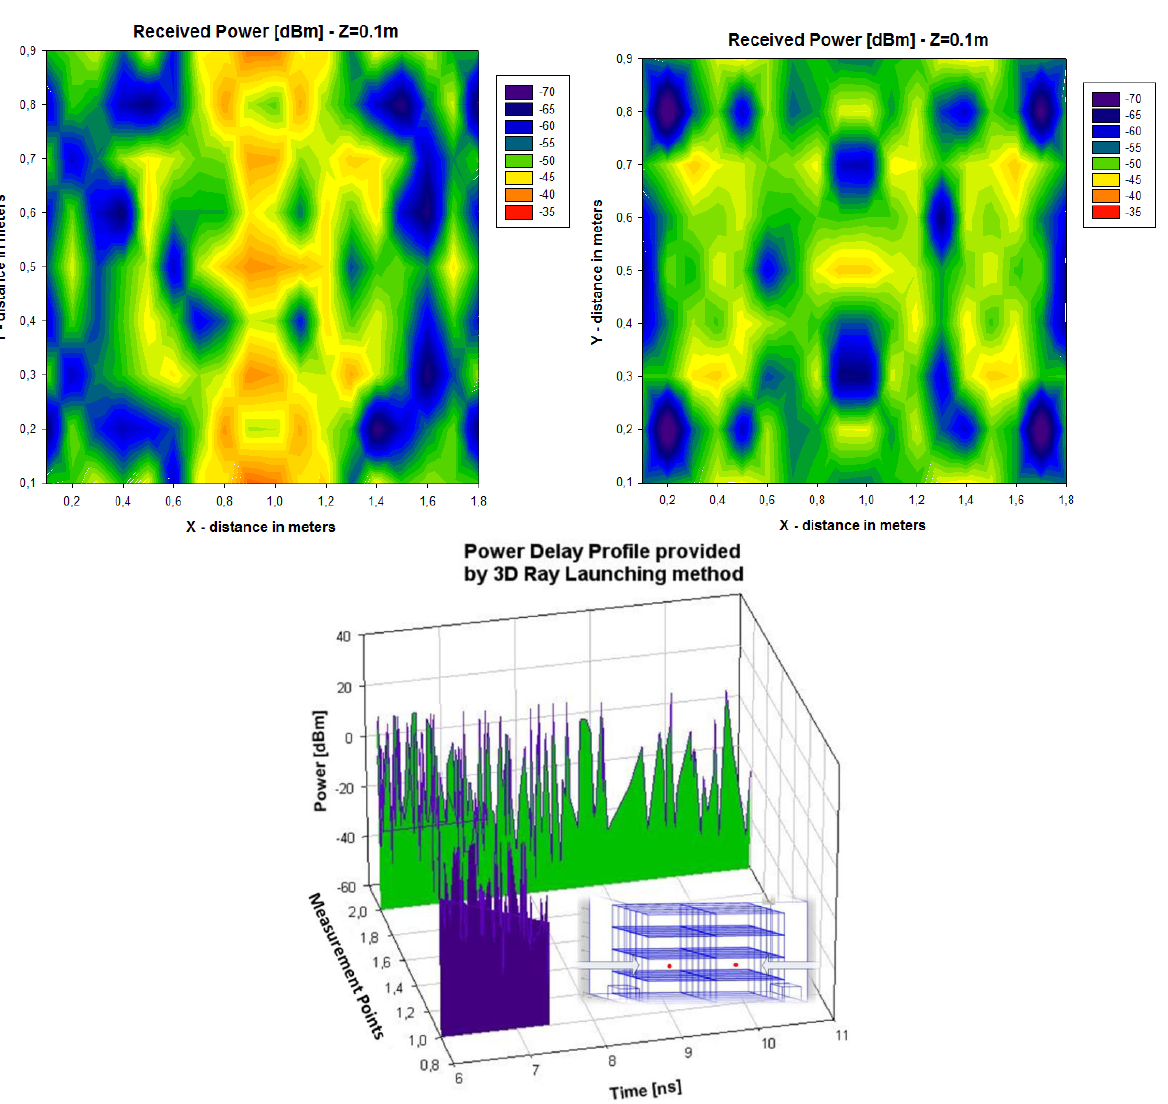
Figure 8. Simulation result of the resulting power distribution within the enclosed vehicle environment, obtained by in-house 3D ray launching code. The left hand figure is the result for the new embedded antenna, whereas the right hand figure corresponds to the conventional one. The bottom figure depicts estimated values of Power Delay Profiles for two different positions within the indoor cargo area of the Intelligent